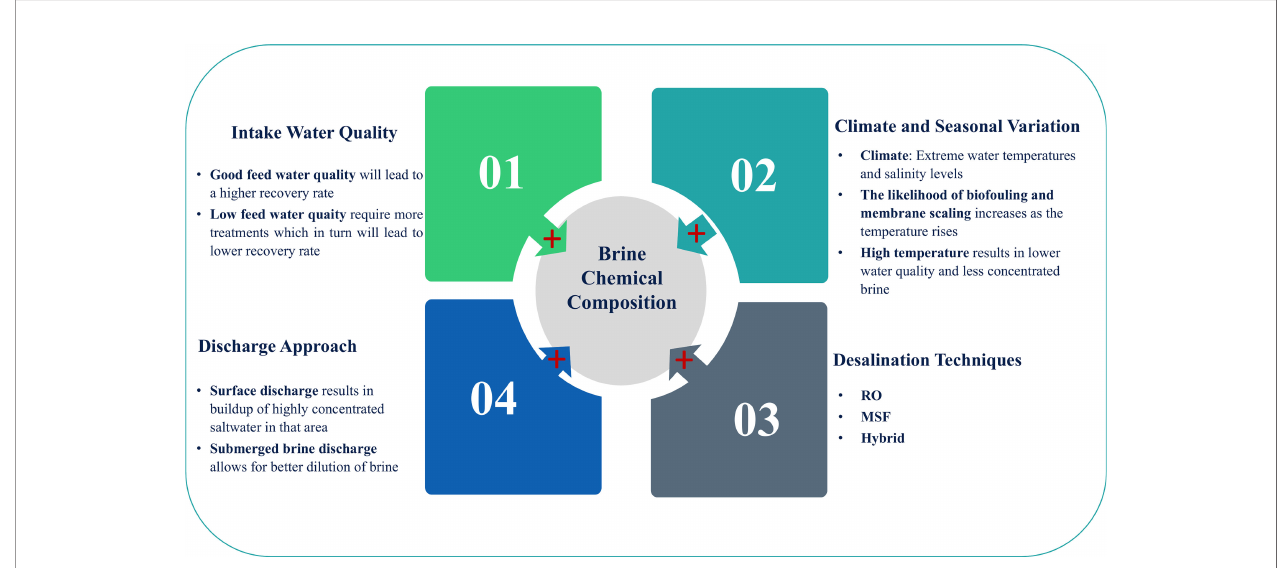
FIGURE 1 | Factors in fl uencing the physicochemical composition of